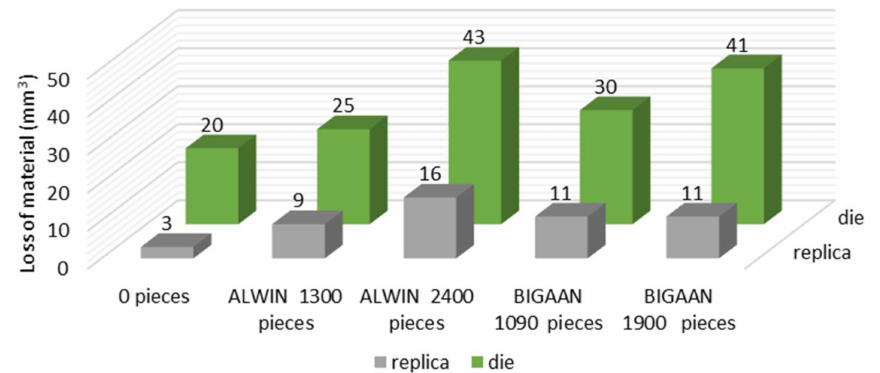
Figure 10. Results of the comparison of the volumetric loss calculated with respect to a new tool for: a new tool scan (illustrating the errors originating from 3D scanning), direct scans of two pairs of tools covered with di ff erent coatings and their corresponding reversed 3D replica